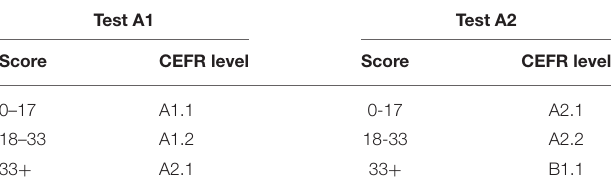
TABLE 1 | Scoring of the L2